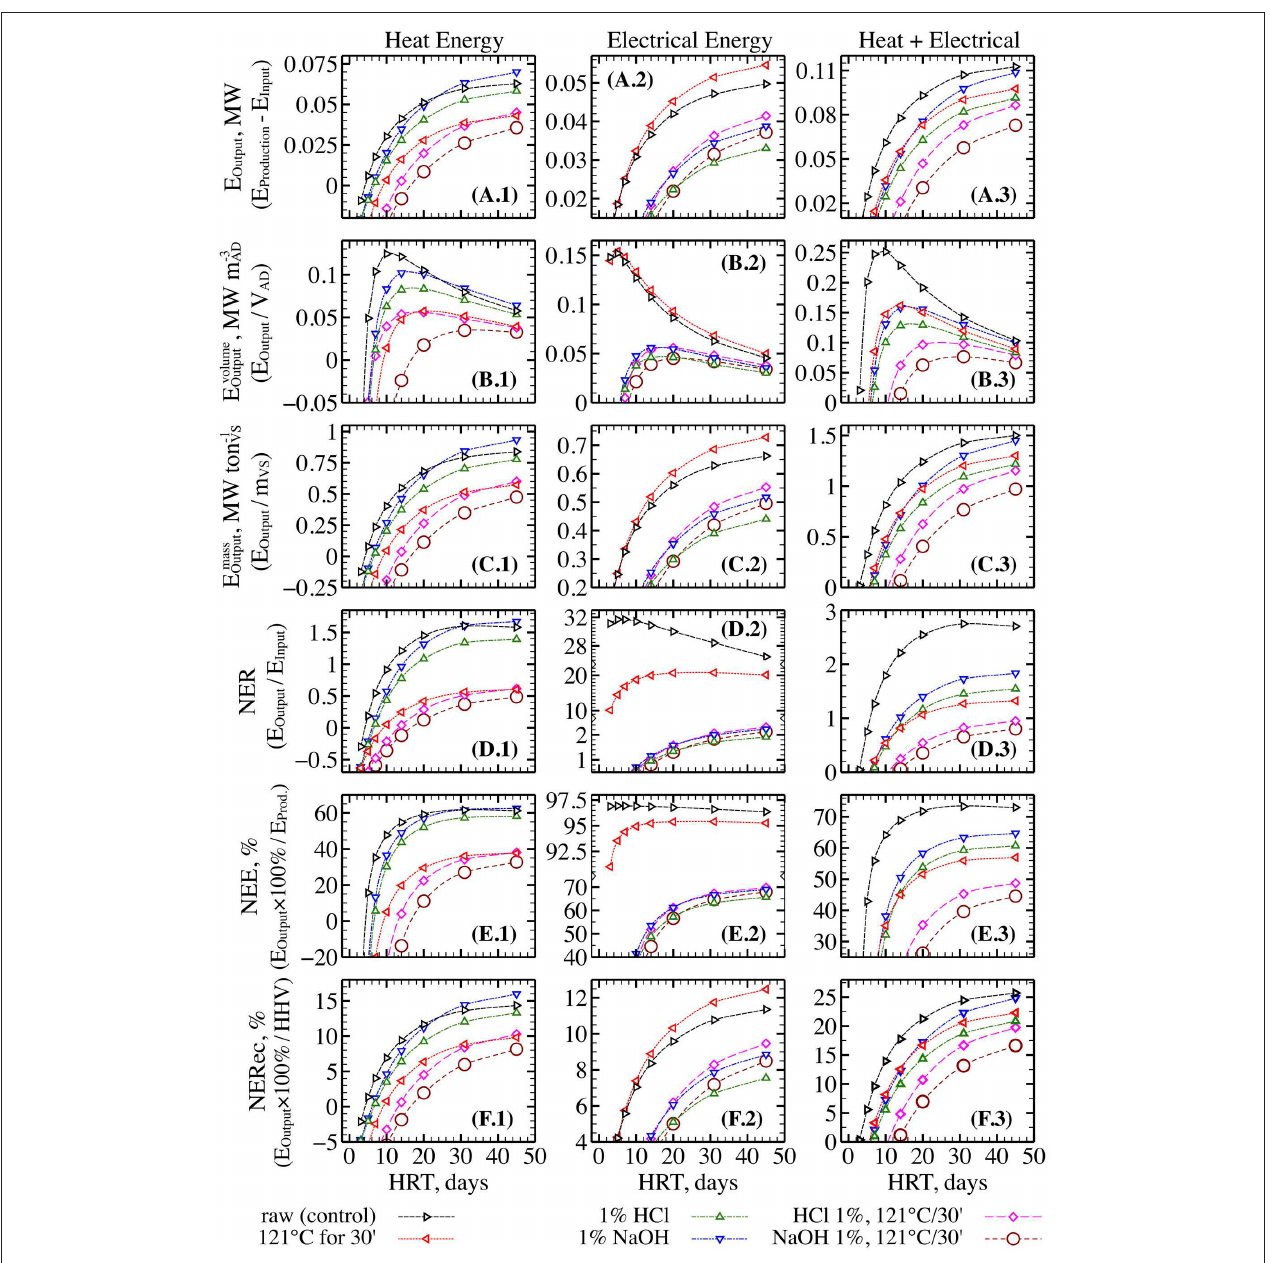
FIGURE 10 | Effect of different types of pretreatment on AD system energy balance parameters including energy output (A) , reactor volume-specific energy output (B) , feedstock mass-specific energy output (C) , Net Energy Ratio (D) , Net Energy Efficiency (E) , and Net Energy Recovery (F) (heat energy left panels, electrical energy central panels, and combined heat and electrical energy right